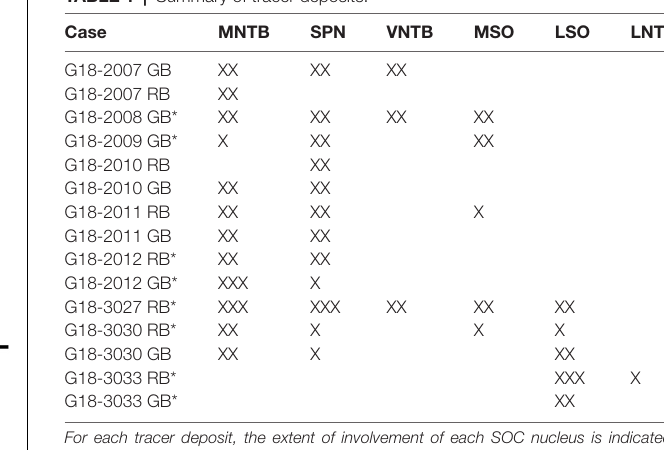
TABLE 1 | Summary of tracer